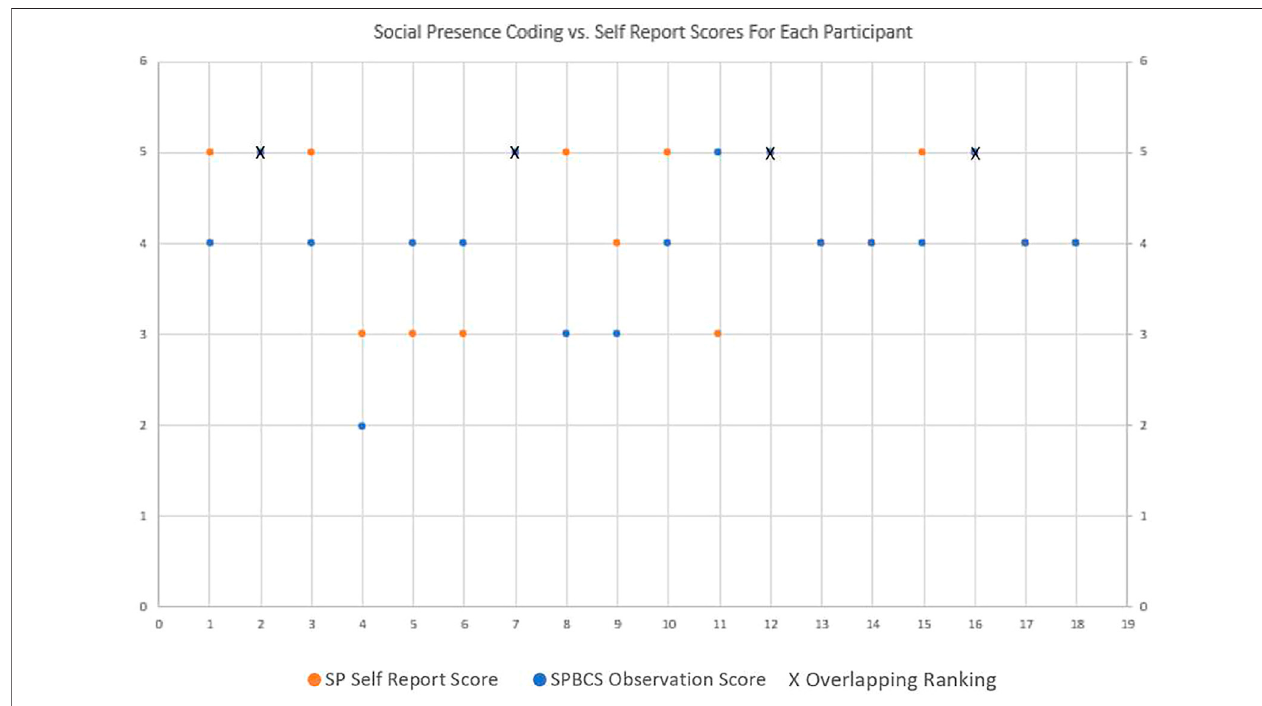
FIGURE3| SocialPresenceCodingvsSelf-ReportScoresdemonstratethetrendofsocialpresencecodingscoreslargelycorrelatingwiththeselfreportscoresof social presence. This ordinal ranking.